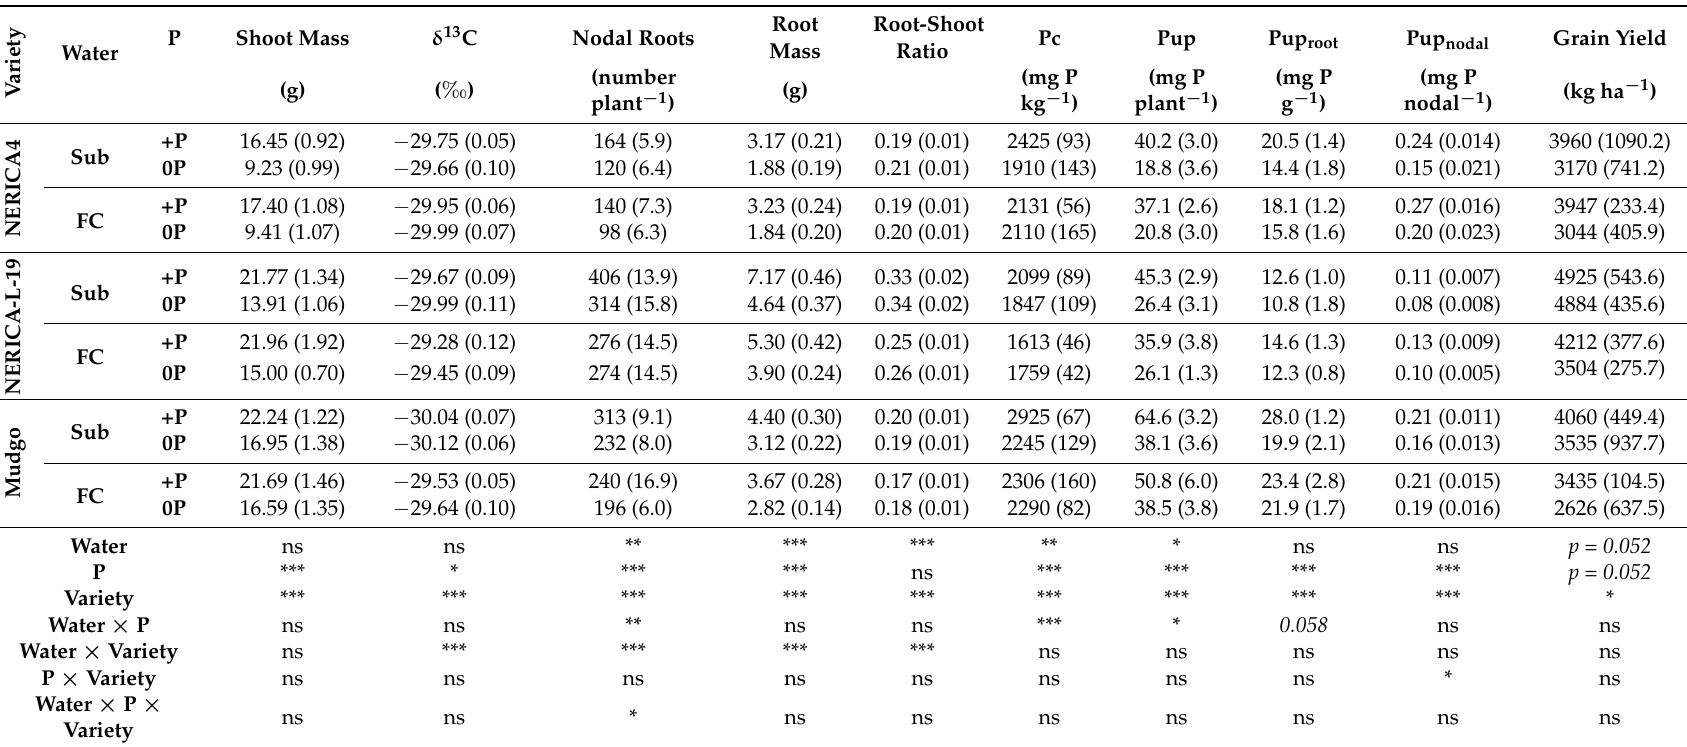
Table 6. Shoot, root, carbon isotope discrimination, and P uptake data from the lowland field trial. Three varieties (NERICA4, NERICA-L-19 and Mudgo) were grown in a lowland field under two different P rates (0 kg P ha − 1 (0P) versus 30 kg P ha − 1 (+P)) and two different water treatments (field capacity (FC) versus submergence (Sub)). Data were collected at 51 DAS except for grain yield which was estimated at crop maturity stage. Data are presented as means with (standard errors). Probabilities of F-statistics for the treatment effects are given at the bottom. (Pc = Shoot P concentration; Pup = Total P uptake by the shoot; Pup root = Shoot P uptake per unit root weight; Pup nodal = Shoot P uptake per nodal